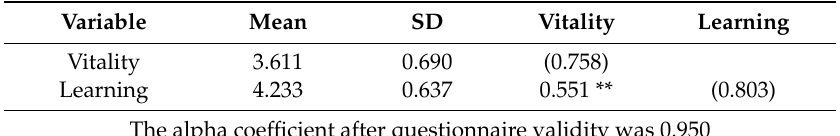
Table 4. Discriminant validity